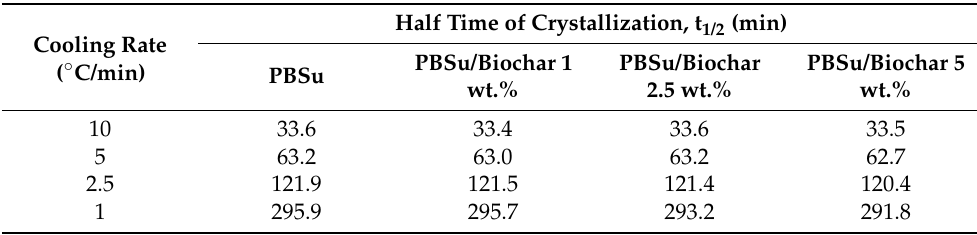
Table 3. Half time of crystallization, t 1/2 , for neat PBSu and PBSu/biochar composites filled with various filler